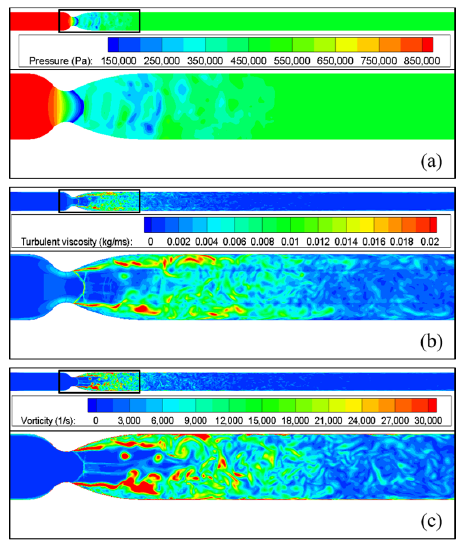
Figure 12. Flow fields for LES: ( a ) static pressure [Pa]; ( b ) turbulent viscosity [kg/ms]; and, ( c ) vorticity [1/s].